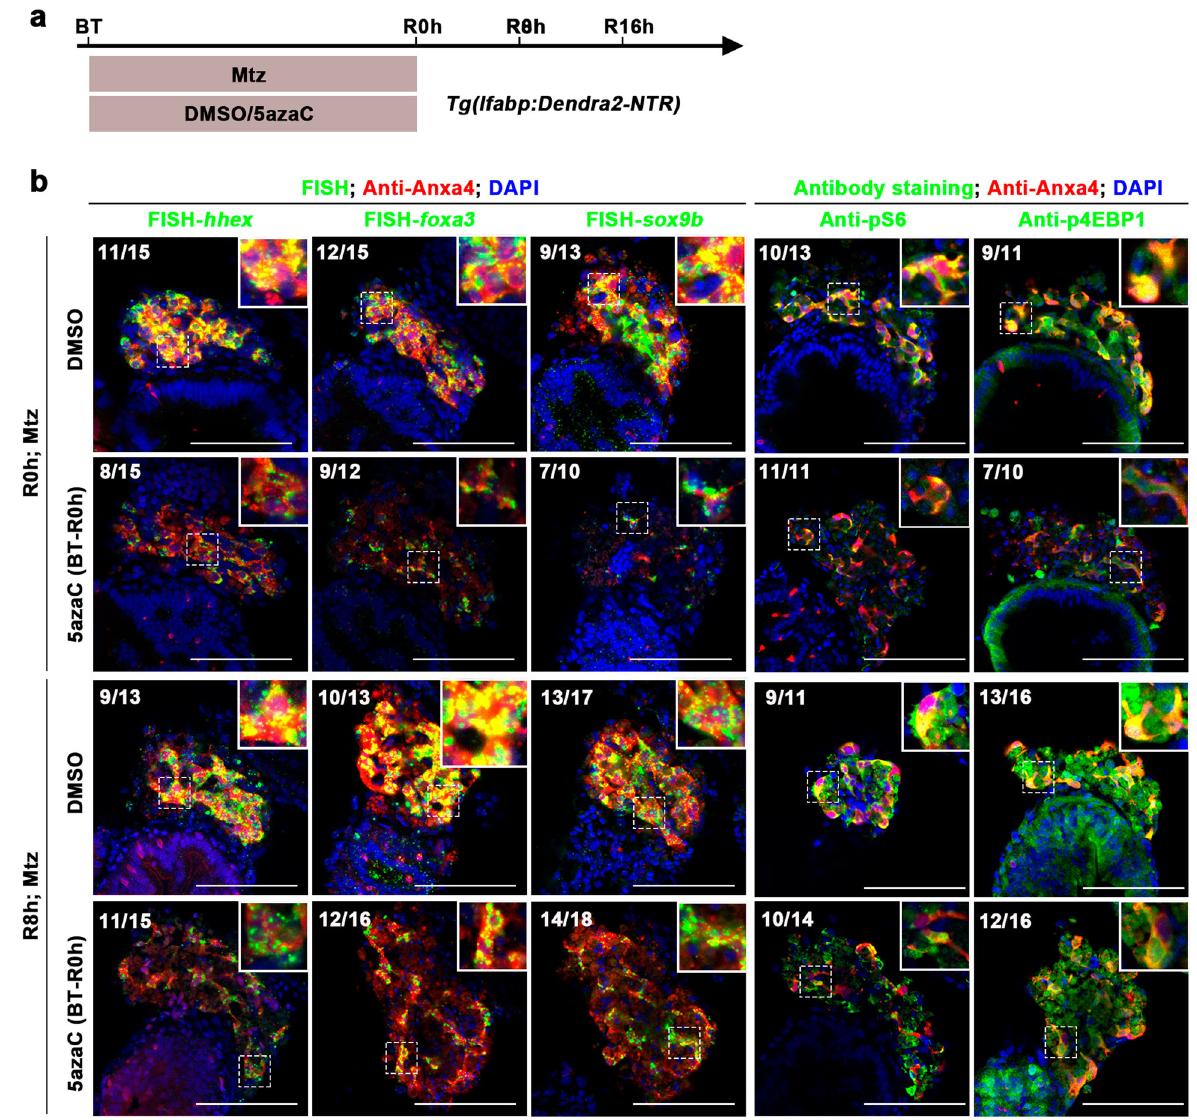
Fig. 2 Early DNA methylation inhibition delays the dedifferentiation of BECs. a Experimental scheme illustrating the 5azaC and Mtz treatment and analysis at R0h and R8h. b FISH and antibody staining showing the expressions of hepatoblast markers hhex, foxa3 , and sox9b and mTORC1 effectors pS6 and p4EBP1 in Anxa4 + cells (2D images) at R0h and R8h after early DNA methylation inhibition. Note that the expression levels of hhex, foxa3, sox9b , pS6, and p4EBP1 were downregulated in 5azaC-treated samples compared to controls. Numbers indicate the proportion of larvae exhibiting the expression shown. Scale bars: 100 µm. DAPI 4 ′ , 6-diamidino-2-phenylindole, BT before treatment, FISH fl uorescence in situ hybridization, R regeneration time after the withdrawal of